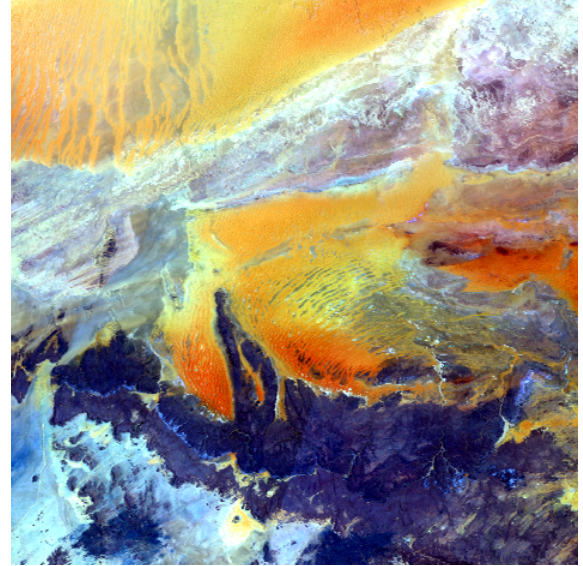
Figure 3. Example of SR 7-day composite, at 300m spatial